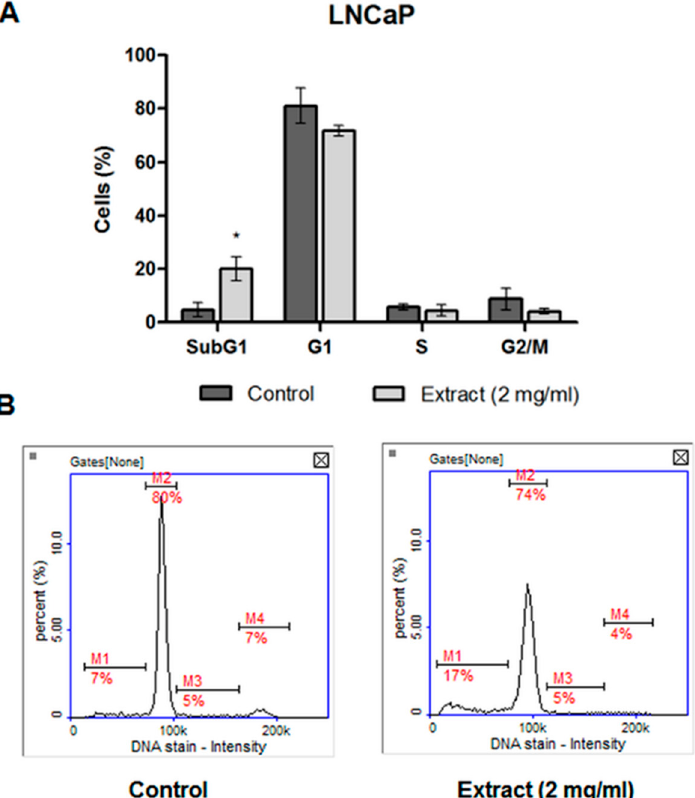
Figure 6. ( A ) Cell cycle analysis in LNCaP cells by image cytometry. The LNCaP cells were treated with 2 mg/mL of CA extract or DMSO as a vehicle in control cultures for 48 h. Data were presented as mean ± SD obtained from three independent experiments. * p < 0.05 vs. control. ( B ) Representative histograms (M1—subG1, M2—G1, M3—S, M4—G2/M phase).